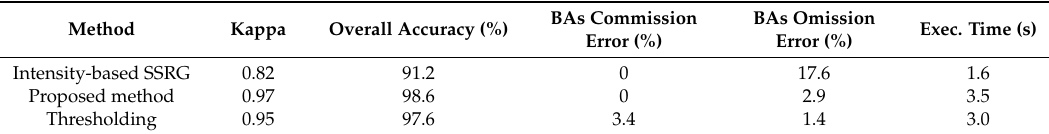
Table 6. Accuracy comparison of results of the proposed method, region growing using only intensity, and thresholding